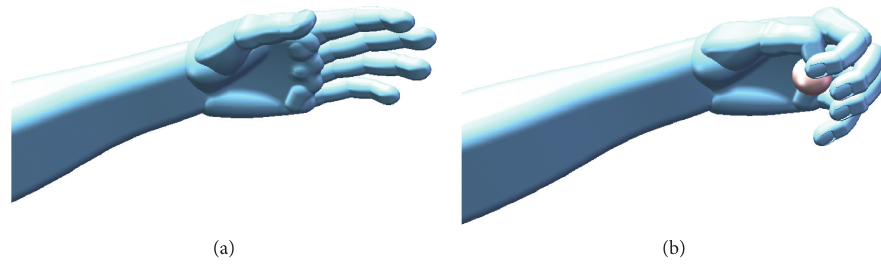
Figure 14: Schematic diagram of the operating space of the